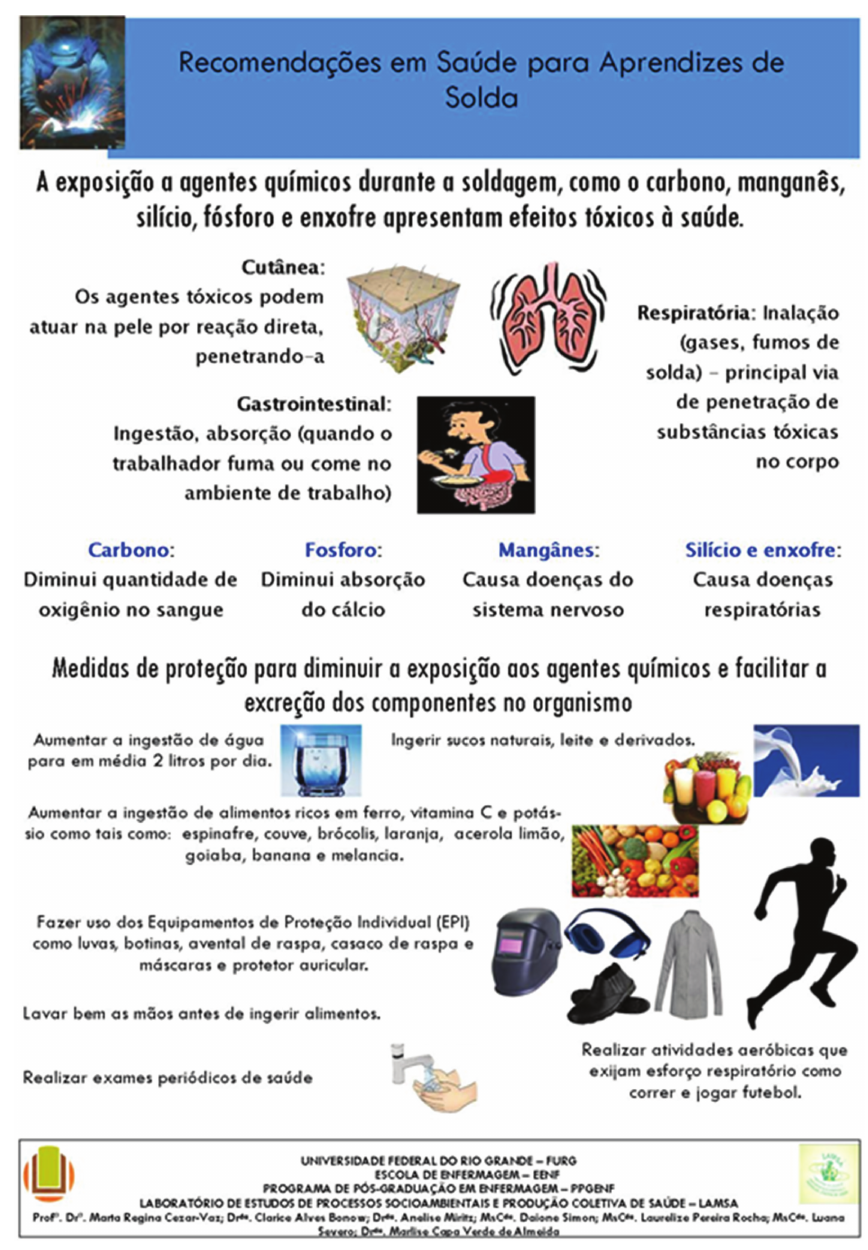
Figure 1: Poster provided from LAMSA for apprentice